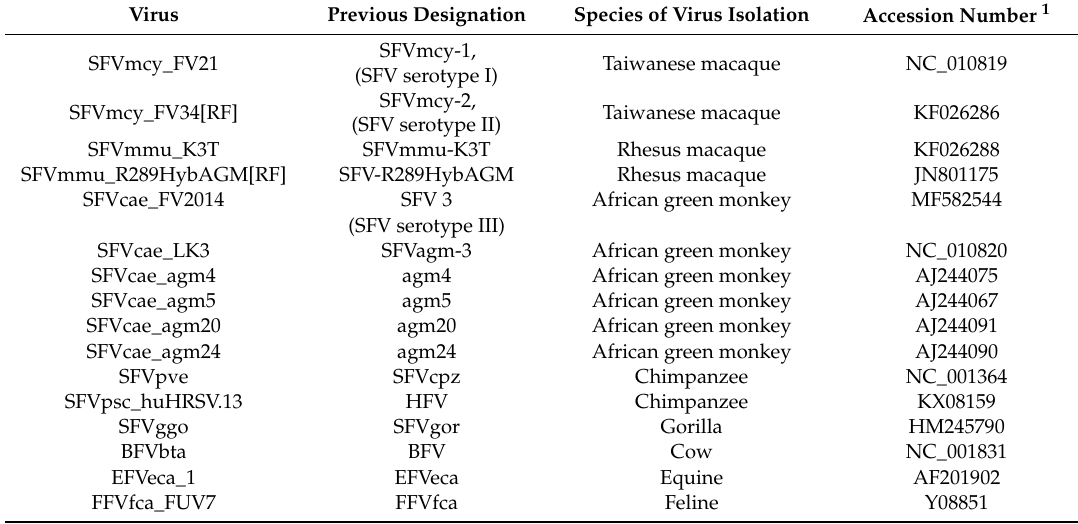
Table 2. Simian foamy virus (SFV) isolates used for phylogenetic analysis and sequence